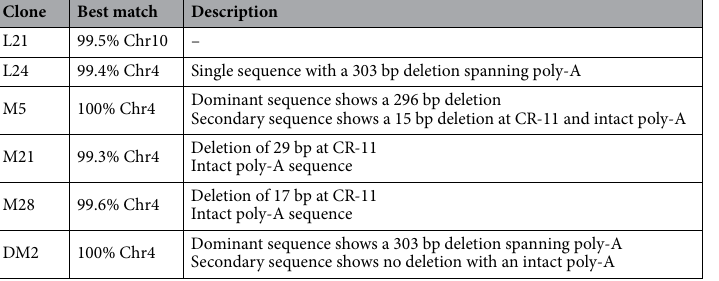
Table 1. Summary of sequencing results in DUX4 exon 3 poly-A targeted single-cell clones of